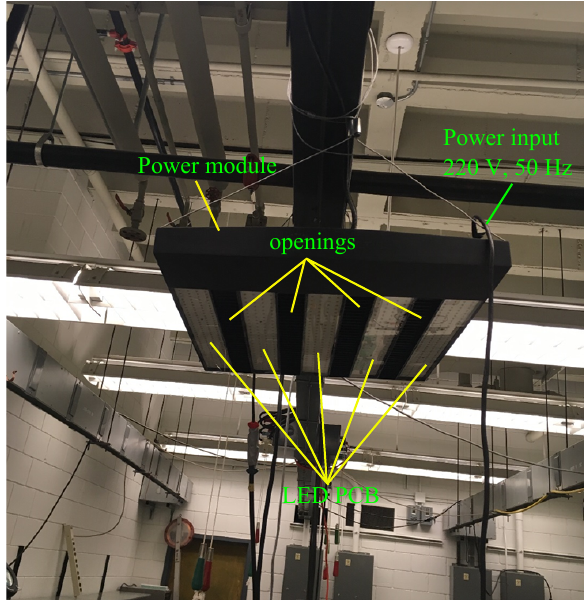
Figure 11. Experimental setup for the natural convection heat transfer of the prototype LED grow light shown in Figure